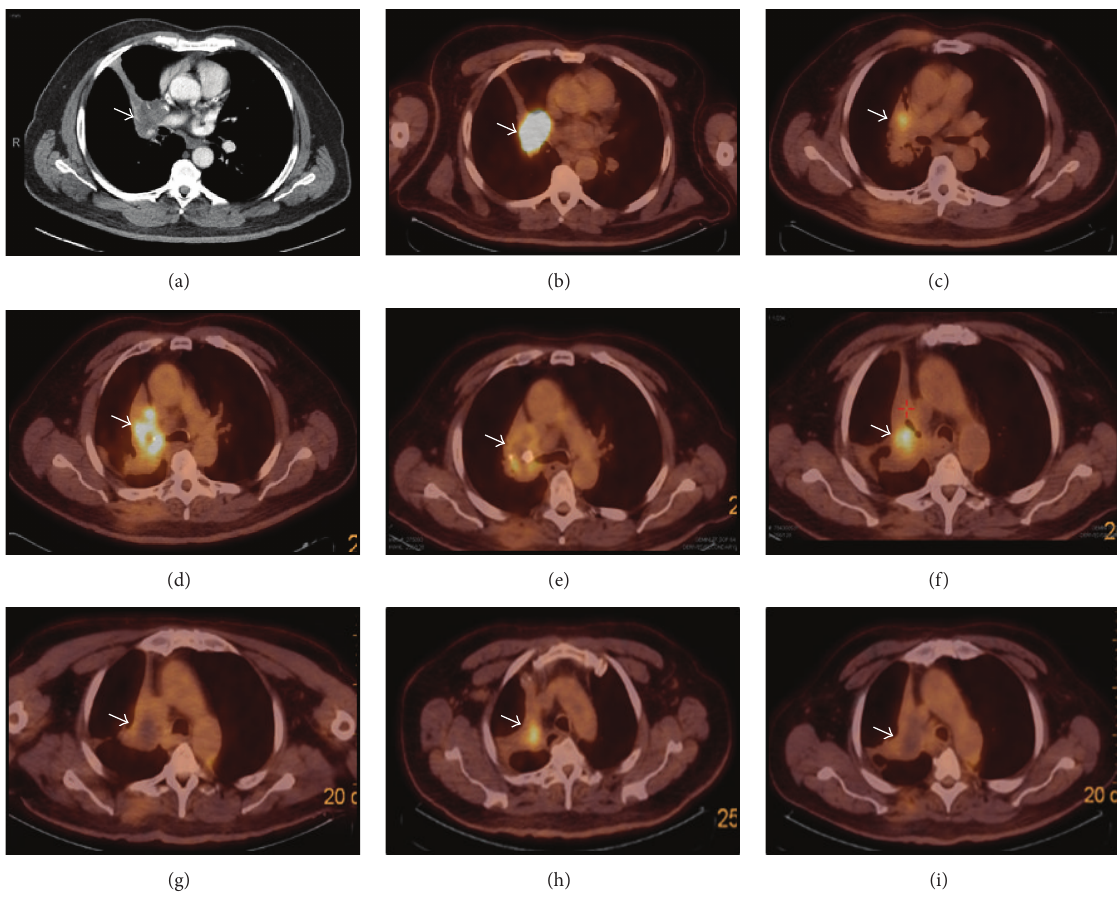
Figure 1: (a) CT scan showed right hilar mass (arrow) in July 2009. (b) PET scan confirmed FDG activity of the mass. (c) Partial response after radiation therapy (October 2009). (d) Extensive disease progression (May 2011). (e) Partial response after chemotherapy (December 2011). (f) Disease progression (March 2012). (g) Reduced metabolic activity after sunitinib (August 2013). (h) Disease progression (September 2014). (i) Complete disappearance of FDG activity with central necrosis after increased dose of sunitinib (February